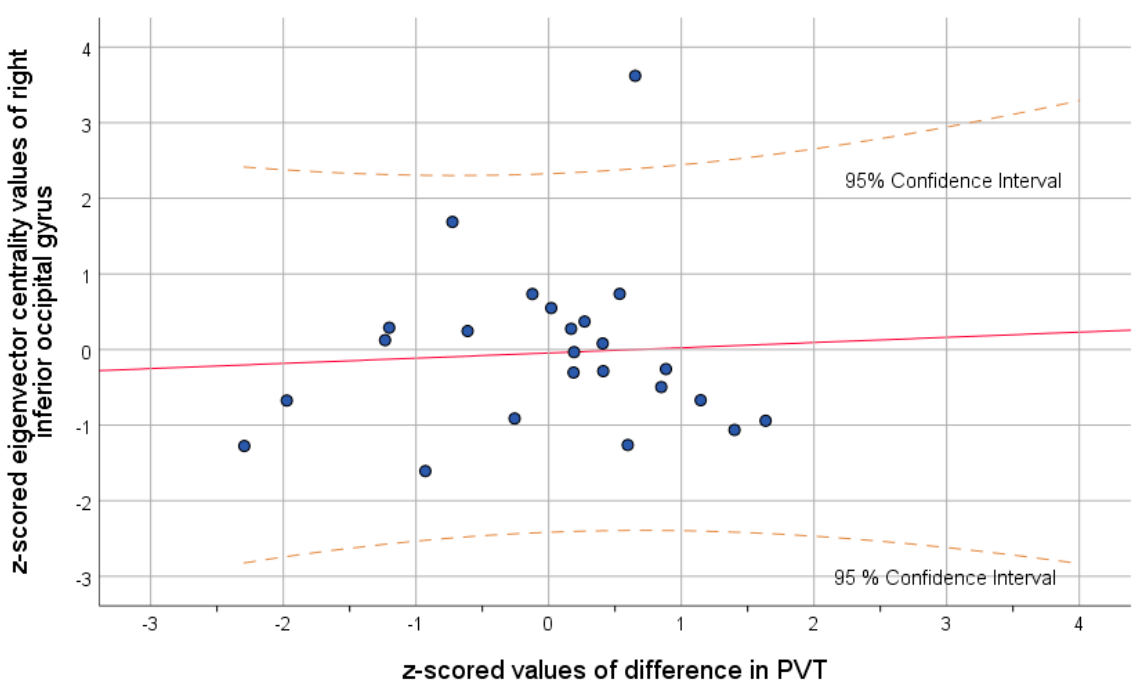
Figure 3. Scatter plot showing the relationship between difference in the reaction time and eigenvector centrality in right inferior occipital gyrus.